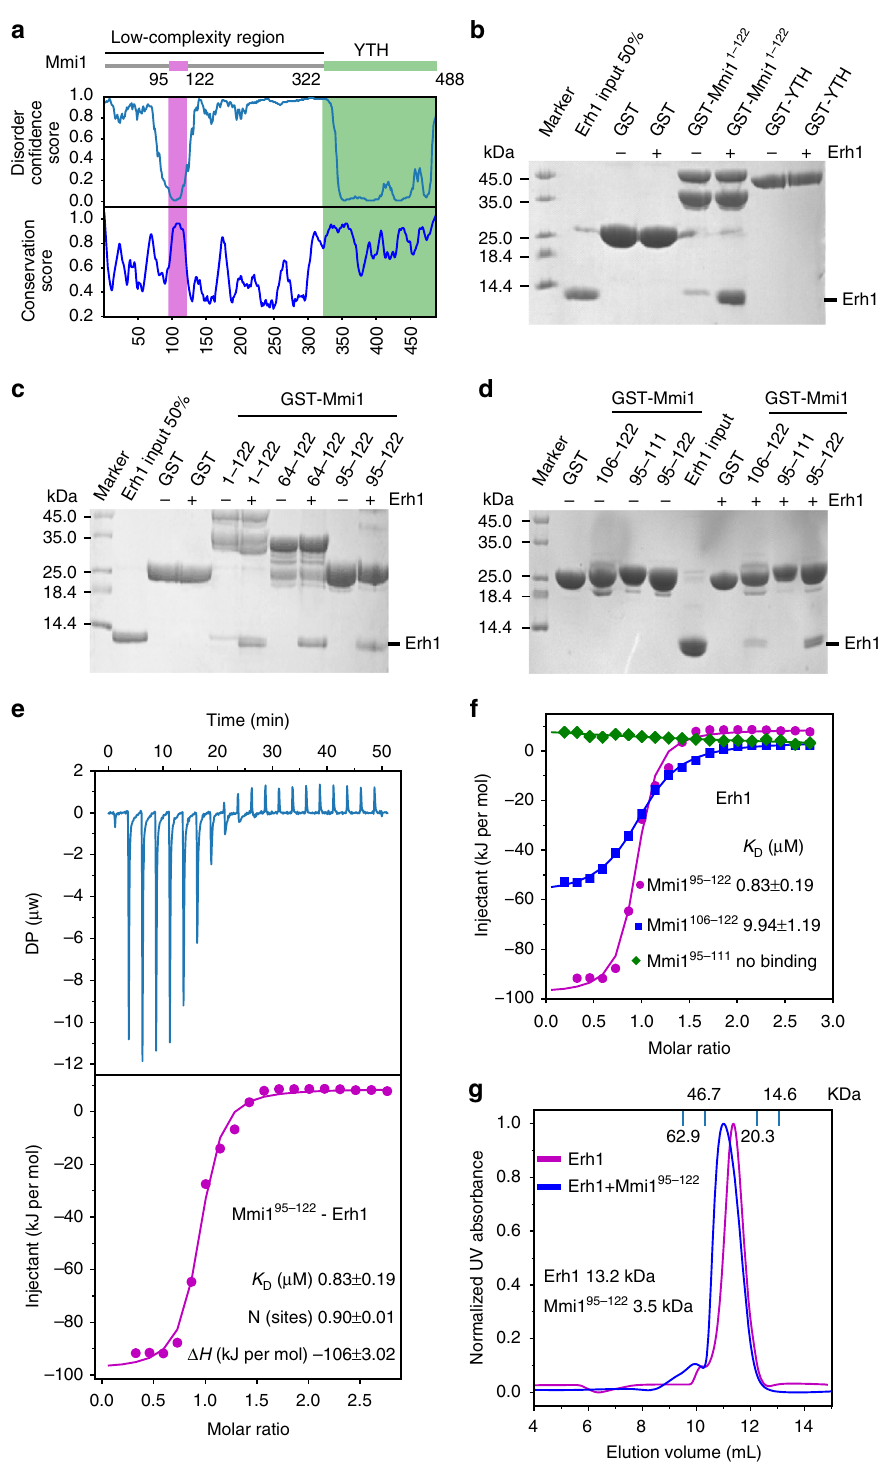
(the 2Fo-Fc electron density map for residues 96 – 119 of Mmi1 is shown in Supplementary Fig.